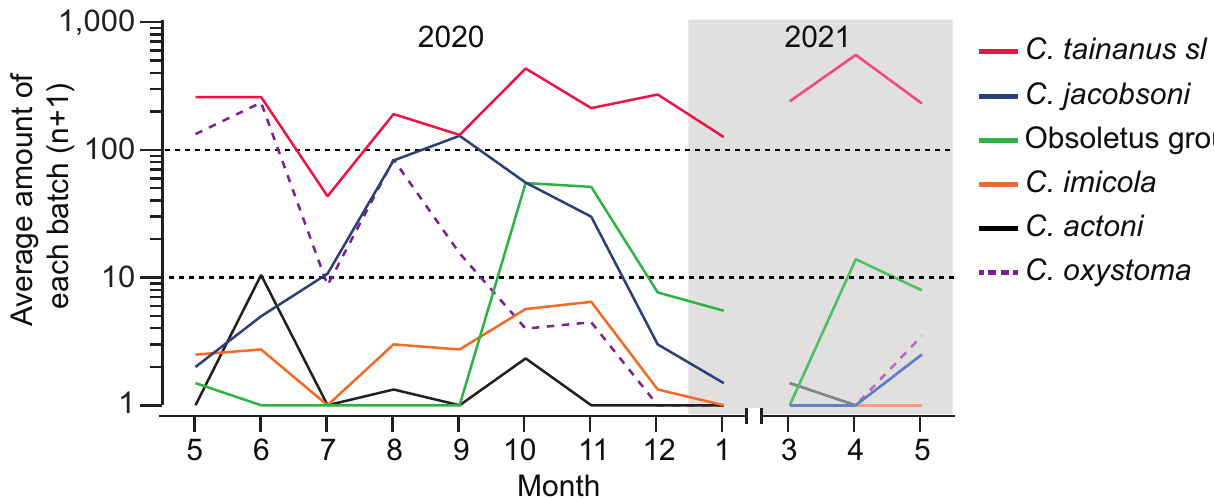
Figure 5. Average monthly numbers of potential BTV vector species at Wulong, Shizong, Yunnan Province, China between May 2020 and May 2021. Logarithm axe and midge amounts ( n + 1) are shown on the y -axis. The period in 2021 is highlighted in a grey